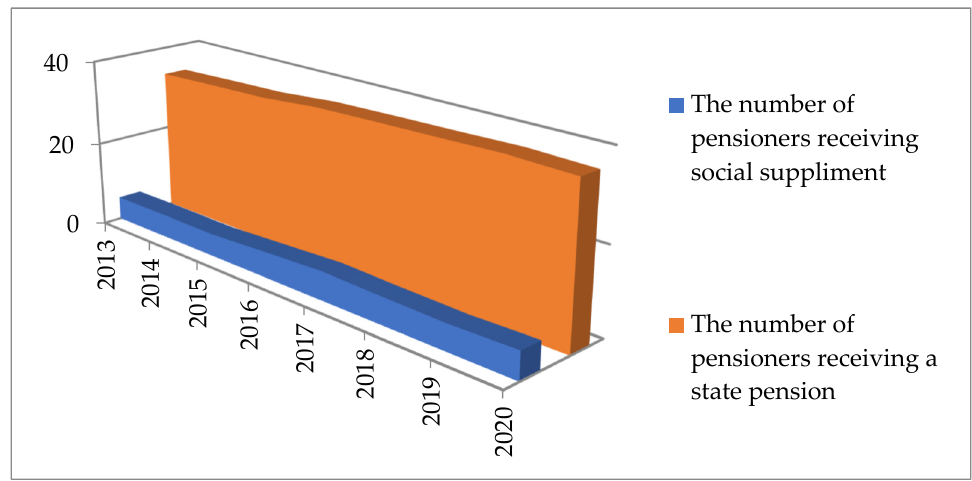
Figure 4. Dynamics of the number of pensioners receiving social supplement to state pension, in millions of people.